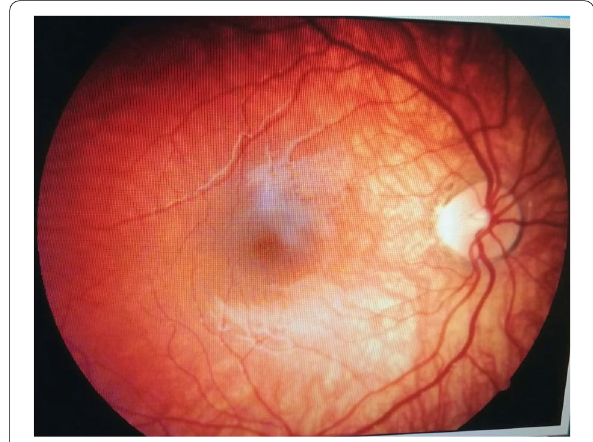
Fig. 4 Fundus image of the girl (proband IV-1) showing bilateral diffuse retinal hypopigmentation and a normal macular profile